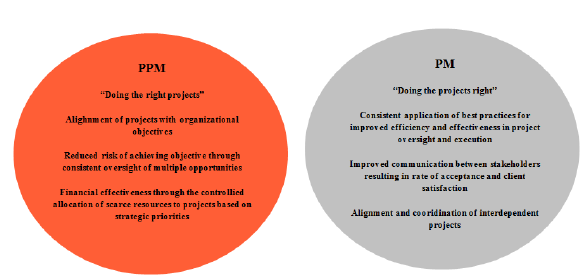
Figure 2: Differences between productive management methods in the construction industry [23] PPM: Project portfolio management; PM: project